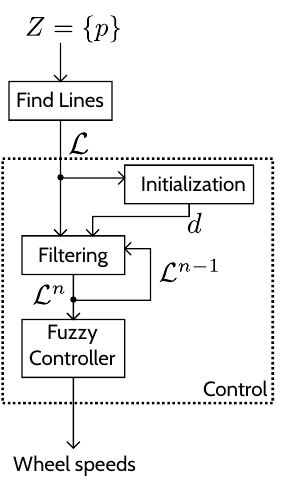
Figure 5. Details of the control